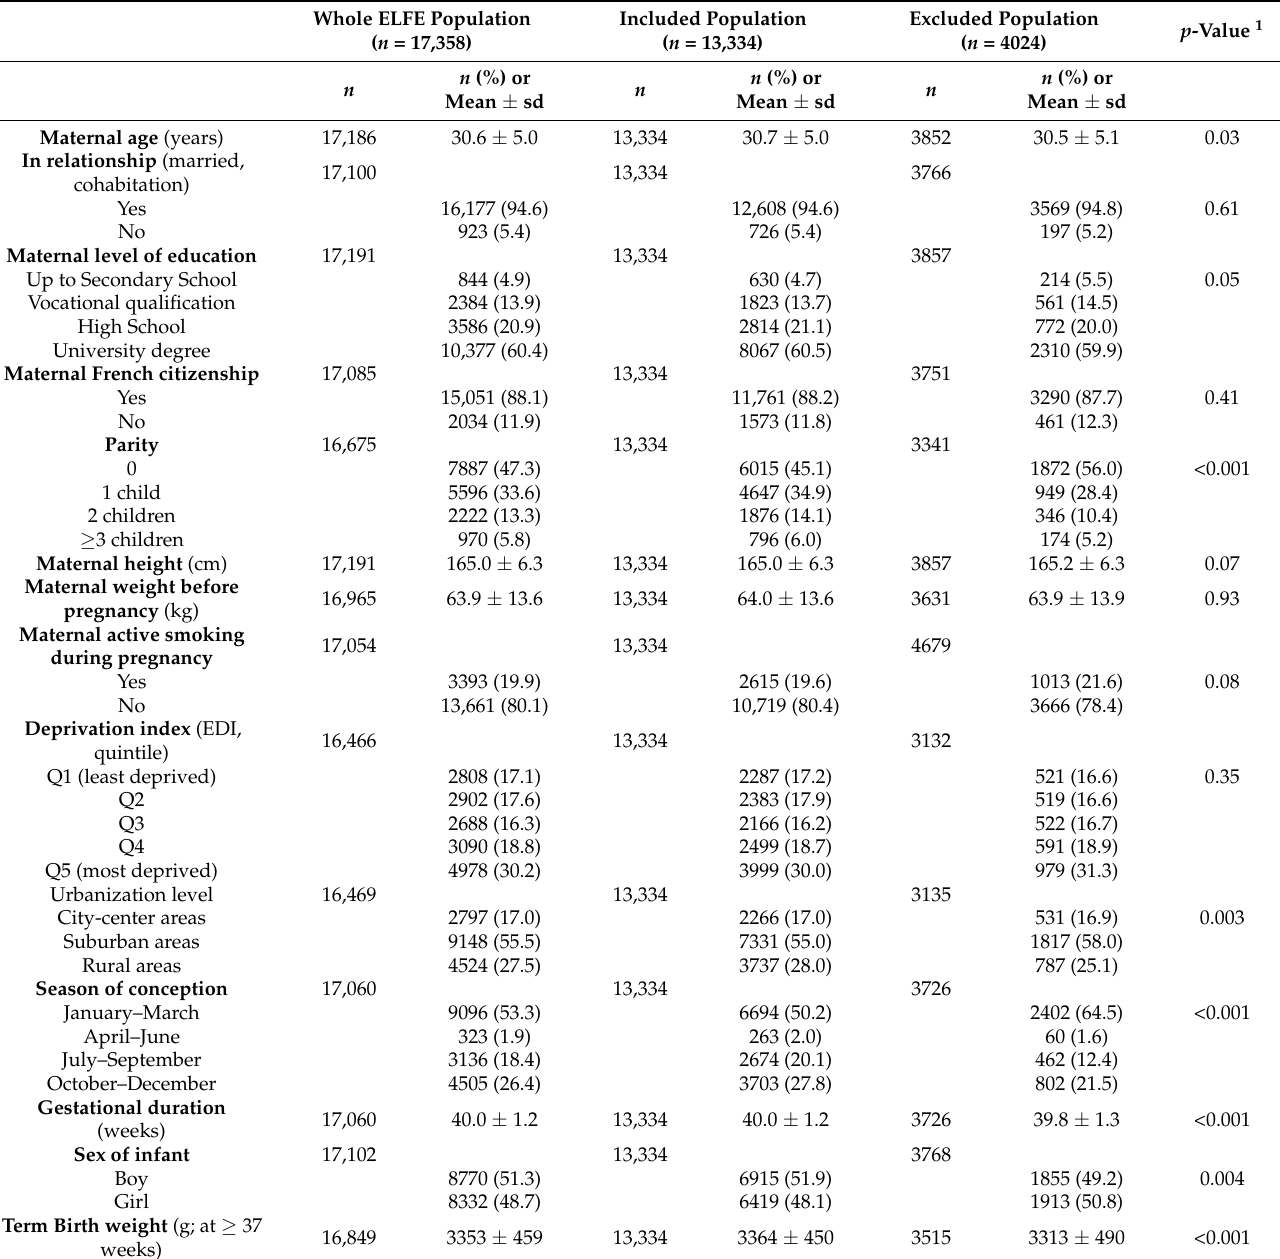
Table 1. Characteristics of the whole ELFE cohort ( n = 17,358), and of the subpopulations included ( n = 13,334) and excluded ( n = 4024) from this study (all groups were restricted to term births, our target